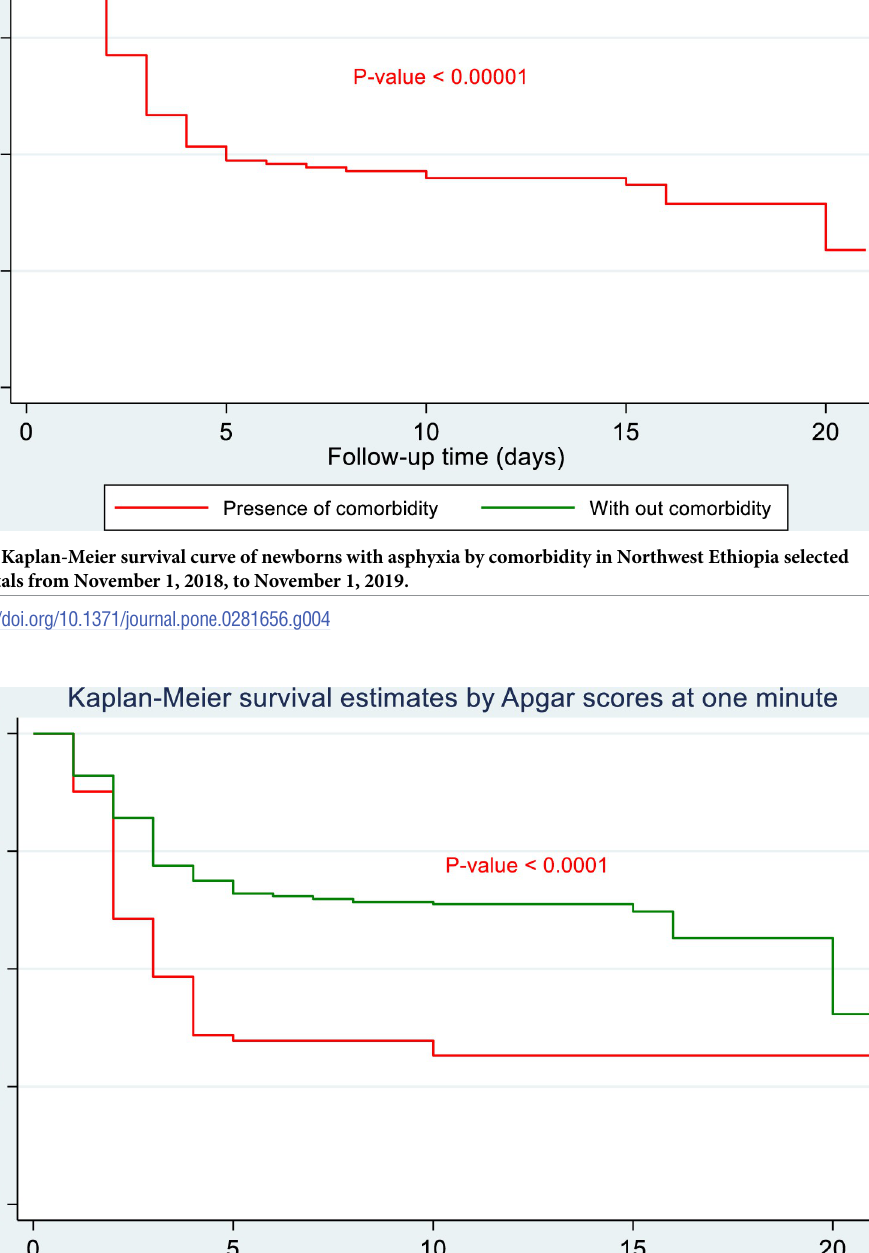
PLOS ONE | https://doi.org/10.1371/journal.pone.0281656 February 24,